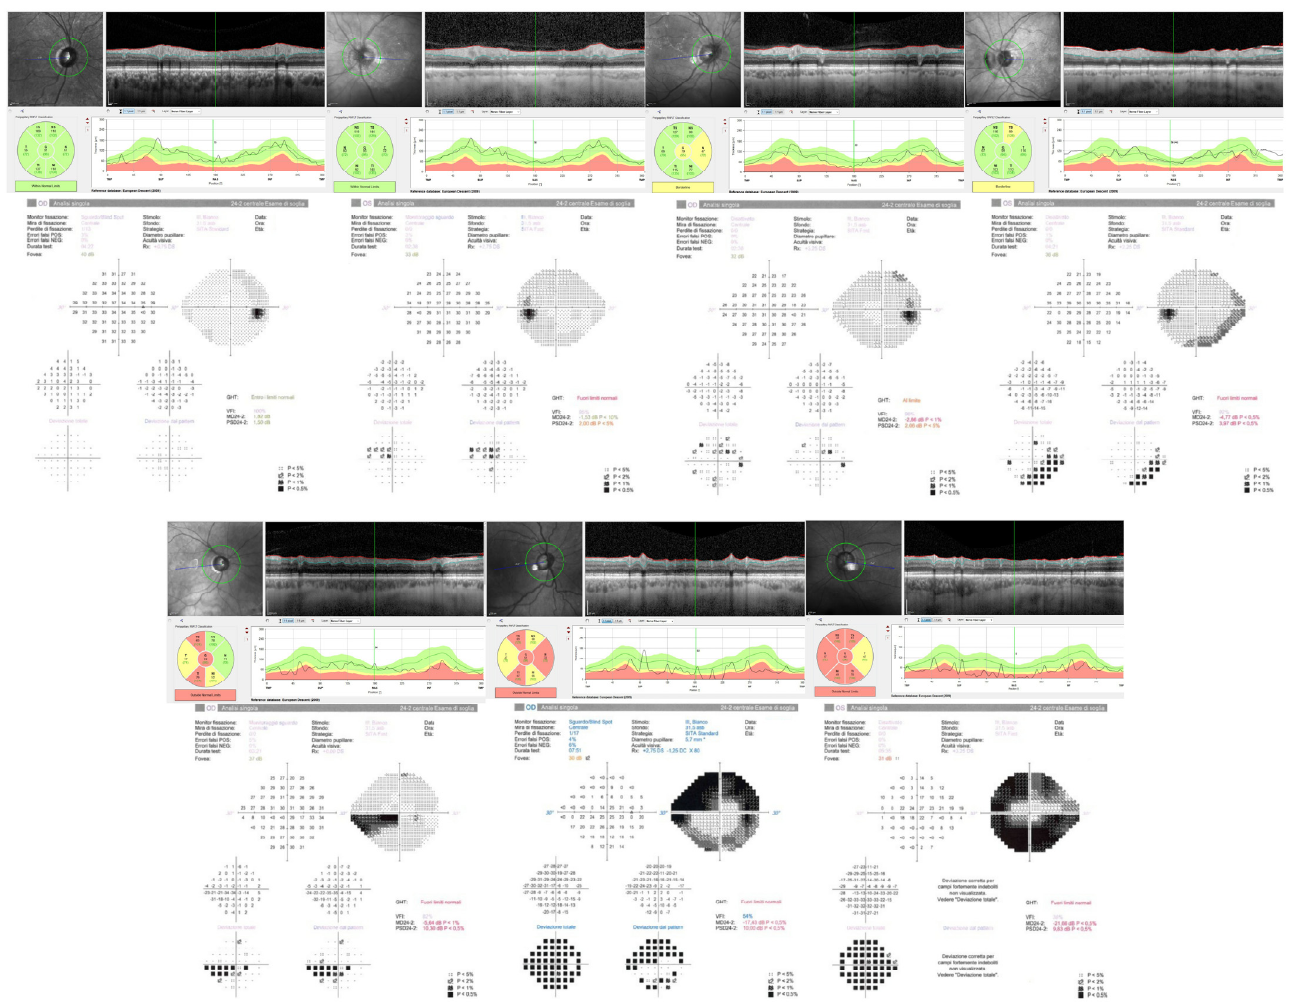
Figure 3. Peripapillary retinal nerve fiber layer and visual fields of patients with different glaucoma stages according to Glaucoma Staging System 2. From left to right, top: stage 0, borderline, 1, 2. From left to right, bottom: stage 3, 4, 5.